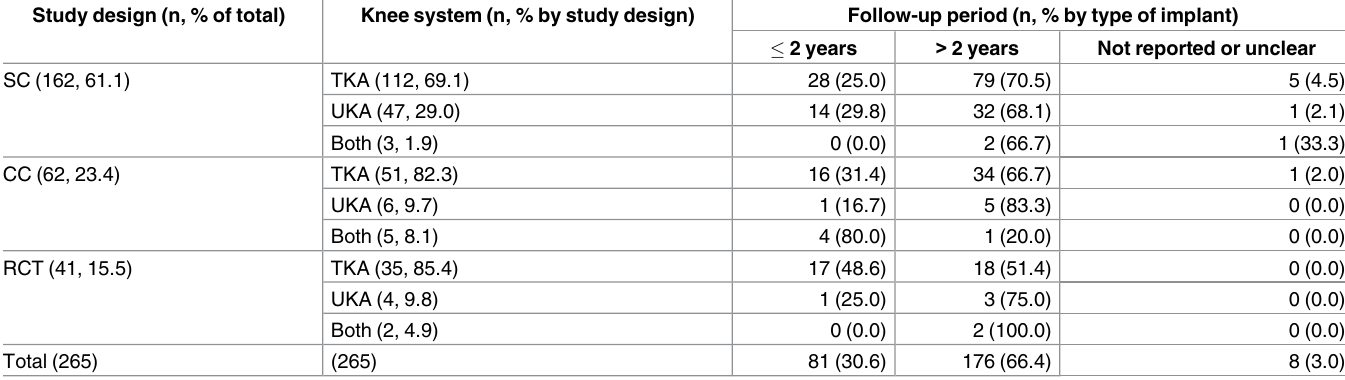
Table 4. Patient follow-up period in eligible studies by study design and knee system. Study design (n, % of